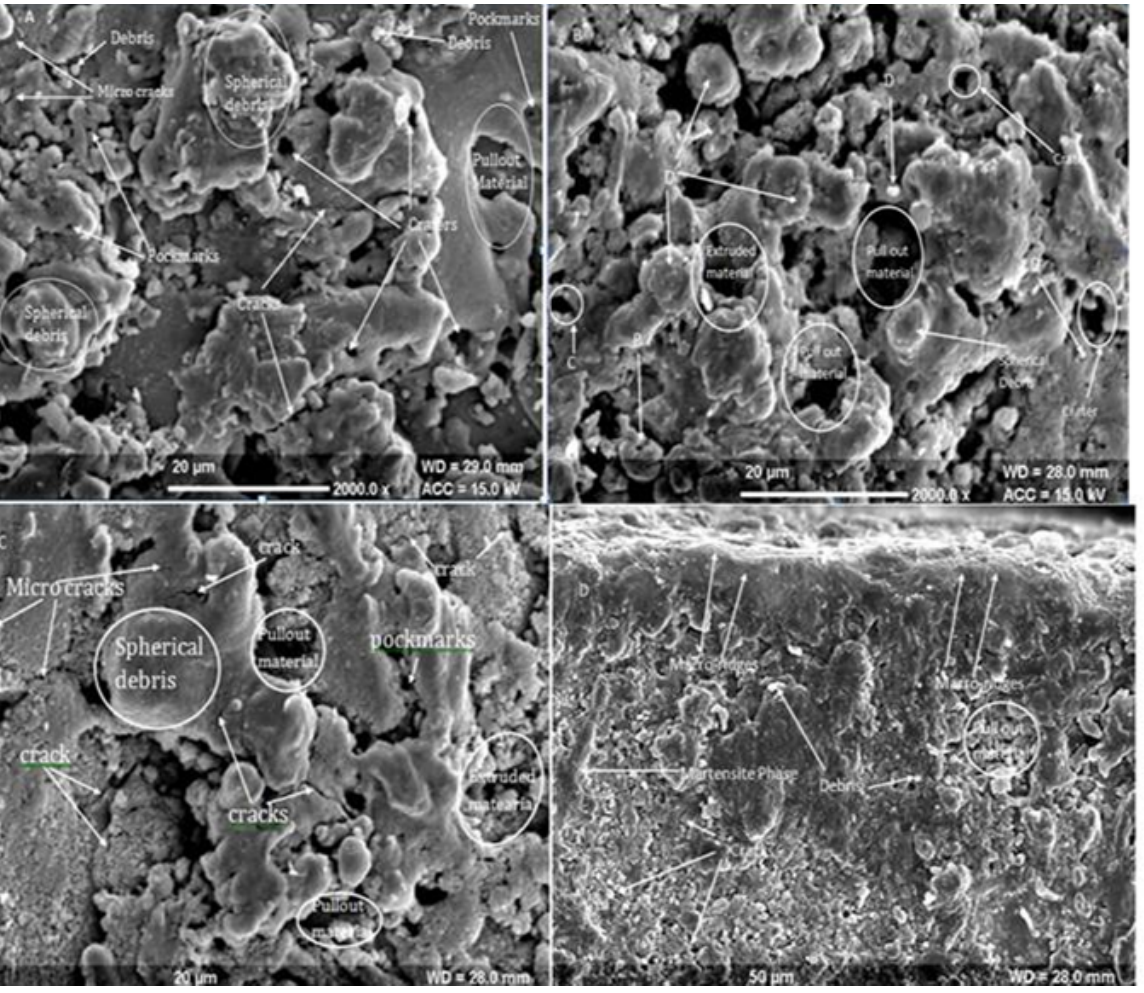
Figure 8: Scanning electron micrographs of work material for